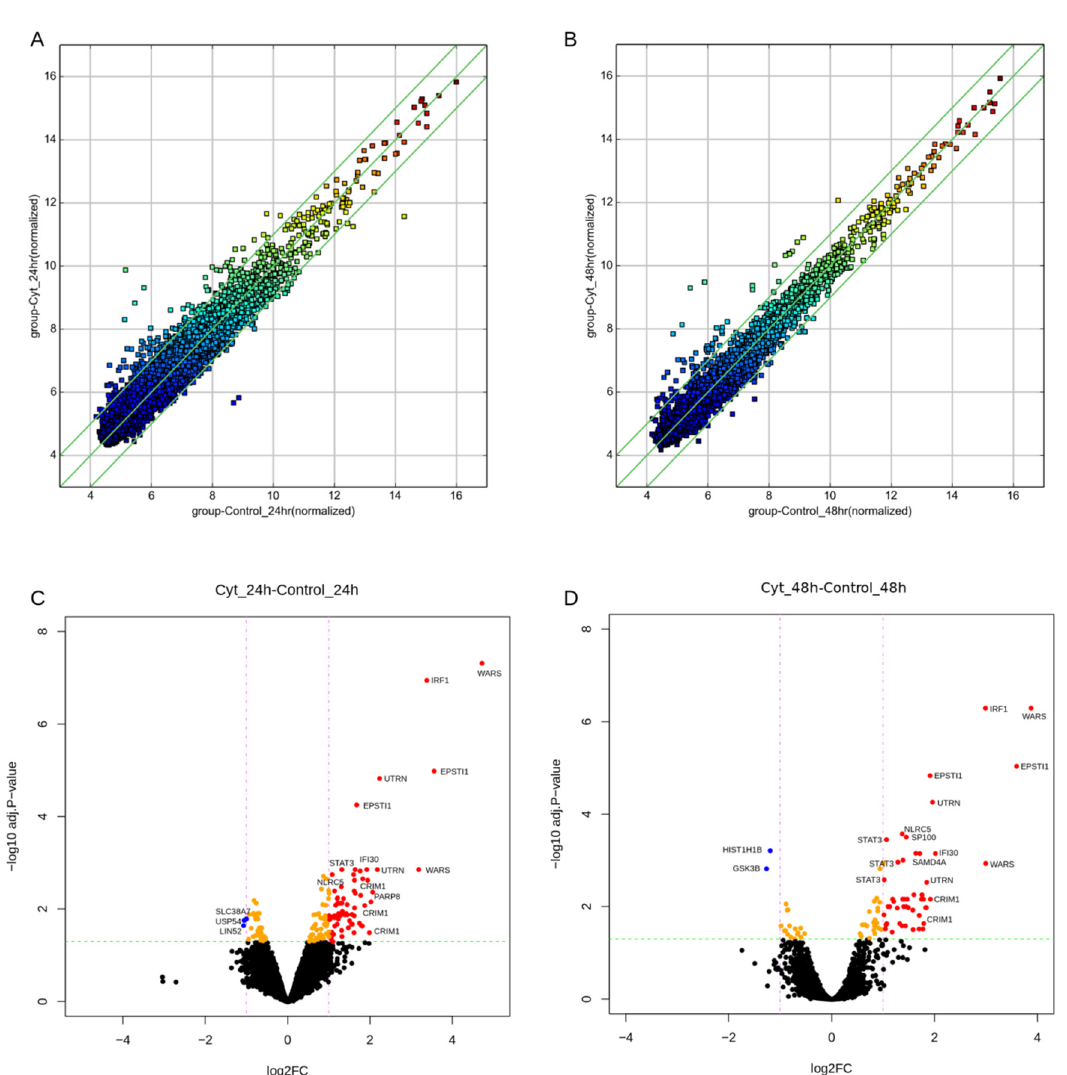
Figure 2. Comparison of circRNA expression profiles between cytokine-treated and non-treated samples at 24 h and 48 h in EndoC- β H1 cells. Scatter plots showing the differences in the expression of circRNAs in cytokine-treated samples compared to control samples at 24 h ( A ) and 48 h ( B ). The middle green line represents no difference between the two groups, while the flanking green lines indicate a change of 2-fold. The circRNAs beyond these lines represent > 2-fold changes between the two groups. Volcano plots of DE circRNAs in human EndoC- β H1 cells after cytokine exposure at 24 h ( C ) and 48 h ( D ). The horizontal and vertical lines represent the adj. p -value and fold-change cutoffs, respectively. The red and blue dots represent the upregulated and downregulated circRNA isoforms, respectively.